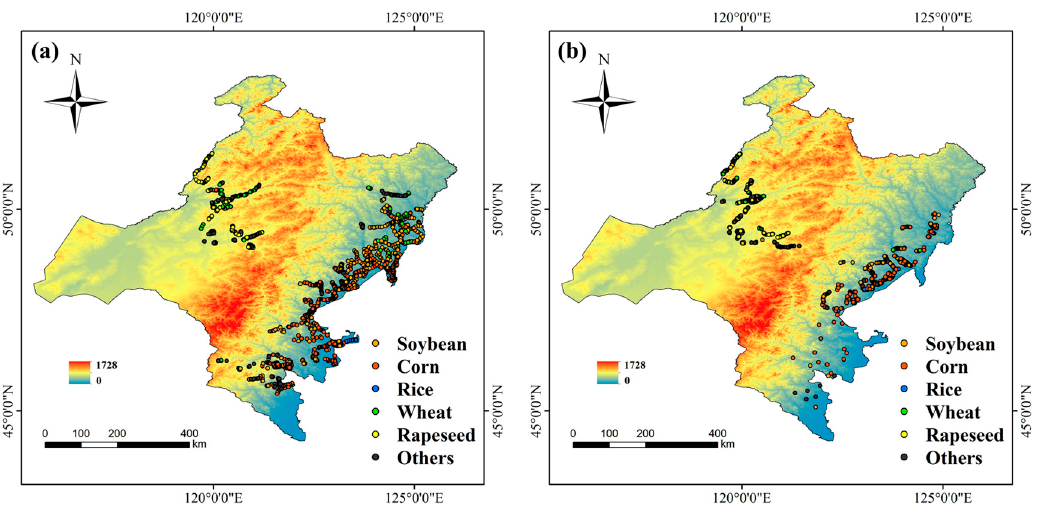
Figure 4. The distribution of field survey samples in ( a ) 2017 and ( b ) 2018. (The base map is a digital elevation model, SRTM90, derived from GEE.). Table 3. The number of selected regions of interest (ROI) in 2017 and 2018.